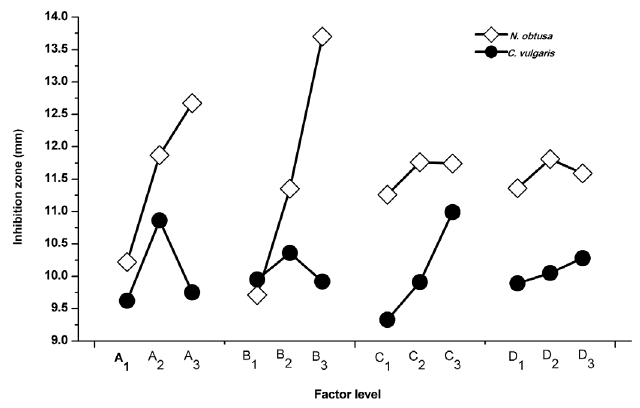
Fig. 3: Effect of each parameter on antimicrobial activities of N. obtusa and C. vulgaris . Parameters of N. obtusa : A, solid to liquid ratio (g:mL):